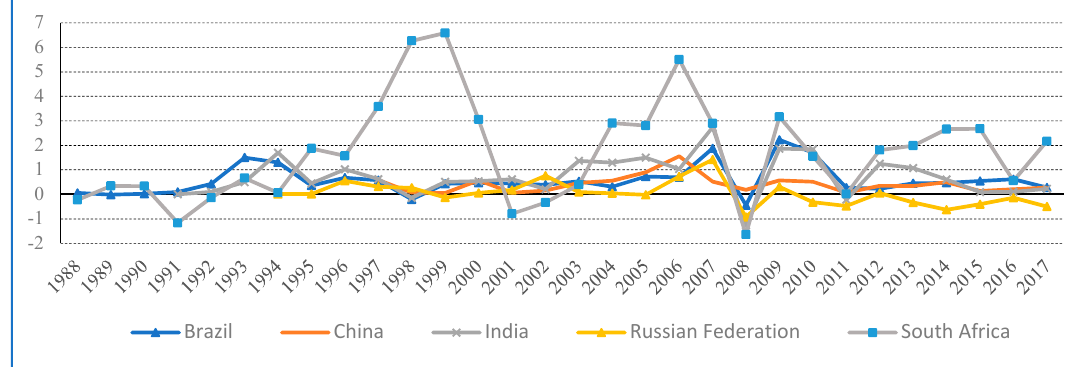
Figure 3. FDI, net inflows (as % of GDP). Source: Own elaboration based on World Development Indicators (World Bank).